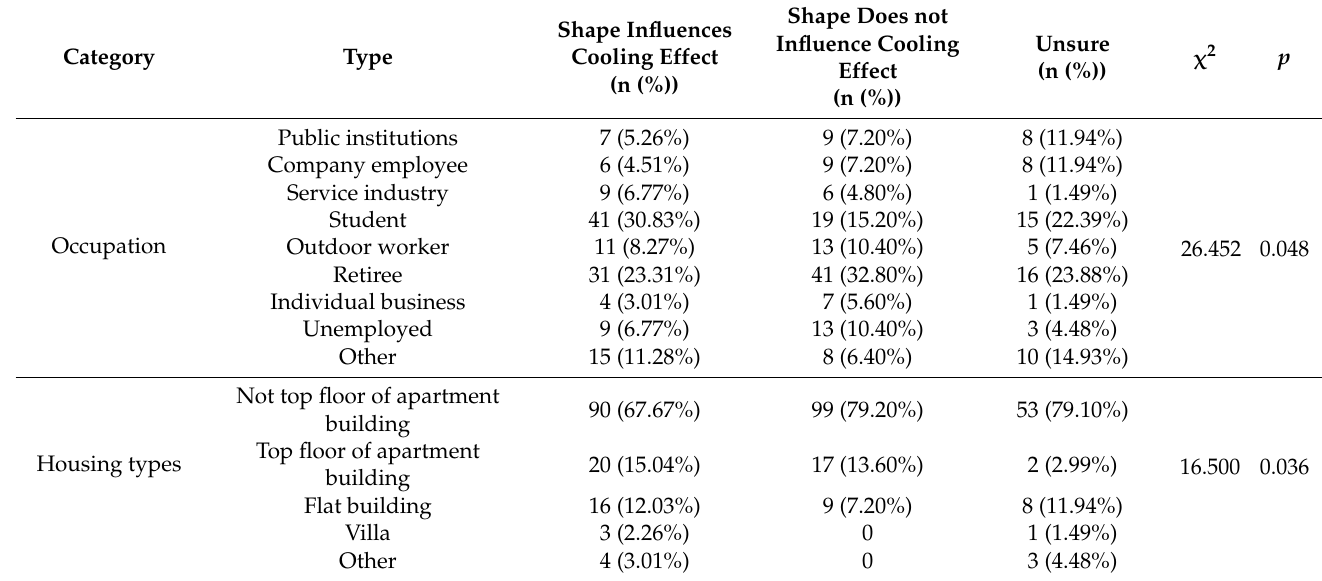
Table 6. Test on the influence of shape on cooling effect for different groups of